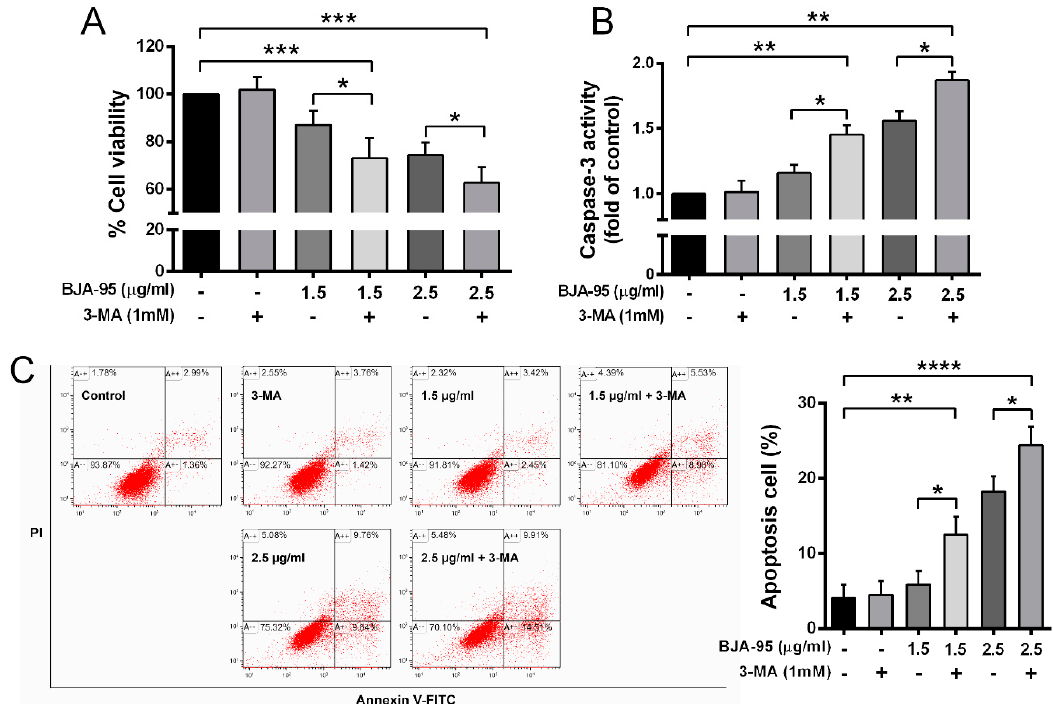
Figure 5. Suppression of autophagy-enhanced BJA-induced apoptosis. ( A ) KKU-213 cells were treated with BJA-95 in the presence or absence of the autophagic inhibitor 3-MA and cell viability was measured using an MTT assay. ( B ) Caspase-3 activity and ( C ) the percentage of apoptotic cells after treatment with BJA-95 in the presence or absence of an autophagic inhibitor. Results are shown as mean ± SD values from three repeated independent experiments. (*) p < 0.05, (**) p < 0.01, (***) p < 0.001 and (****) p < 0.0001 when compared with the control.